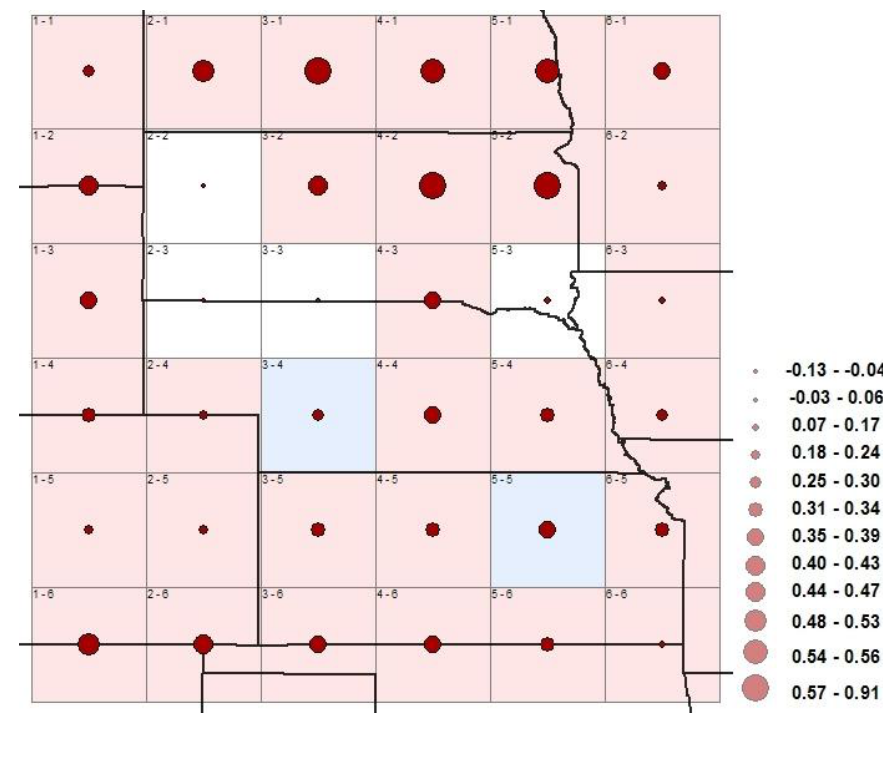
Figure 5. Spatial signatures of climate response to CO regional climate. Red grids indicate areas with significant warming signal, white grids indicate areas with insignificant CO cooling signal. The solid red circles represent the magnitude of the amplitudes of CO in each